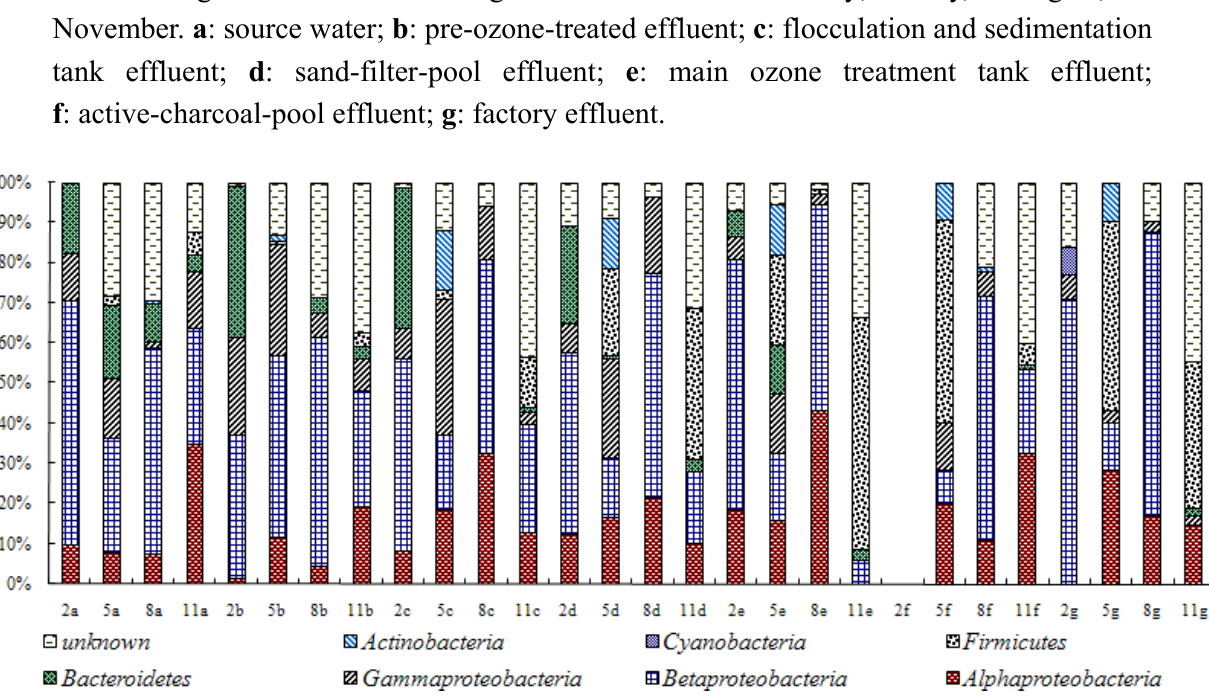
Figure 3. Composition of the major phylogenetic groups found in water sample